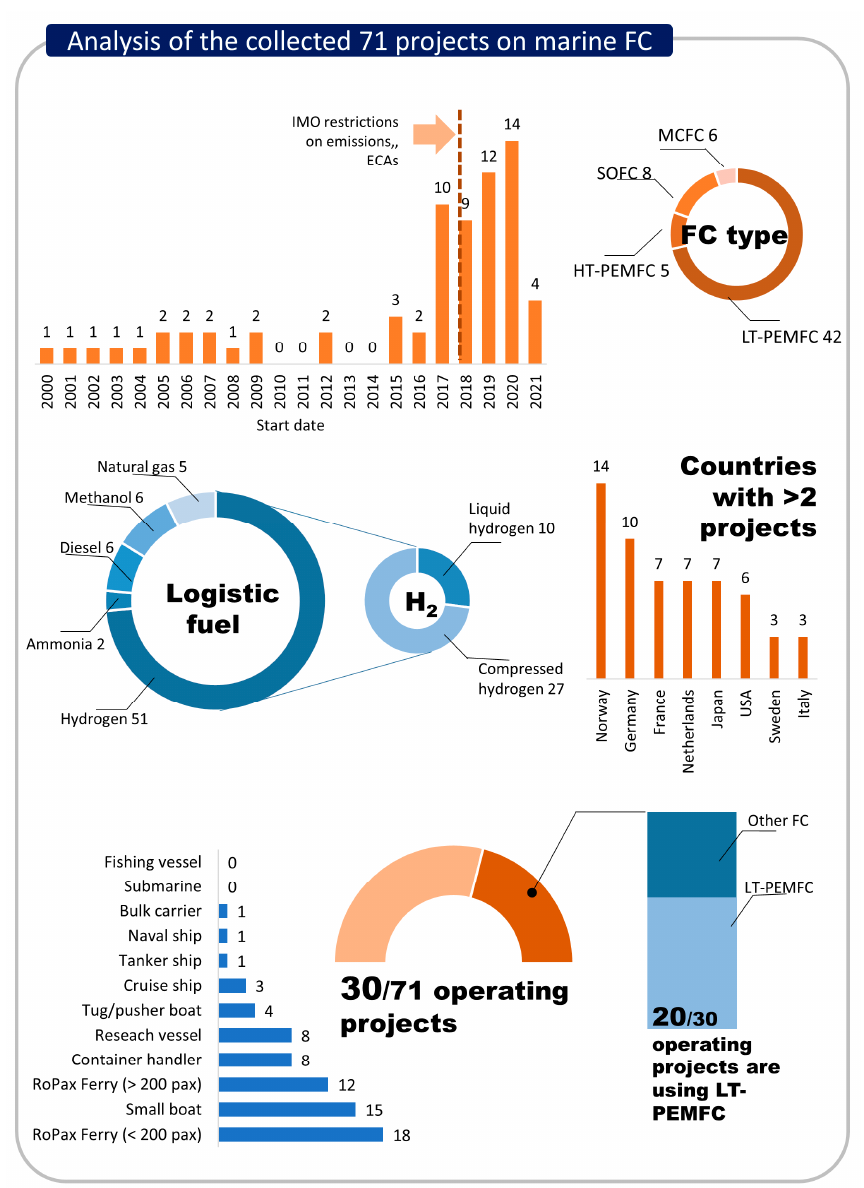
Figure 3. Infographic reporting the analysis of the 71 collected projects available in the attached database (see Supplementary Material). Numbers indicate the number of projects according to the respective criterion. Operating projects refer to those where the vessel is currently in service/has navigated at least once. (Acronyms used in the FC type chart: MCFC = molten carbonate FC; SOFC = solid oxide FC; HT-PEMFC = high-temperature PEMF; LT-PEMFC = low-temperature PEMFC.)